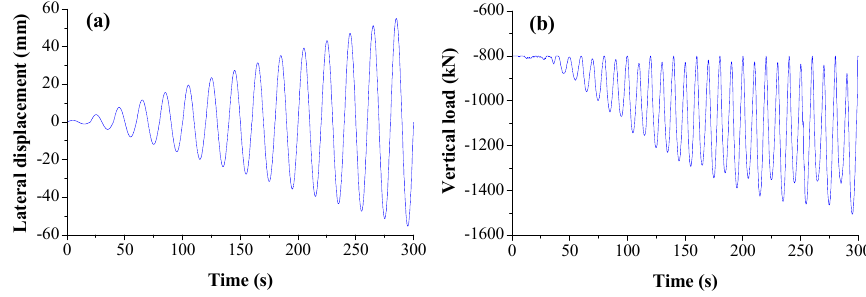
Figure 6. Loading scheme for: ( a ) lateral direction; and ( b ) vertical direction.